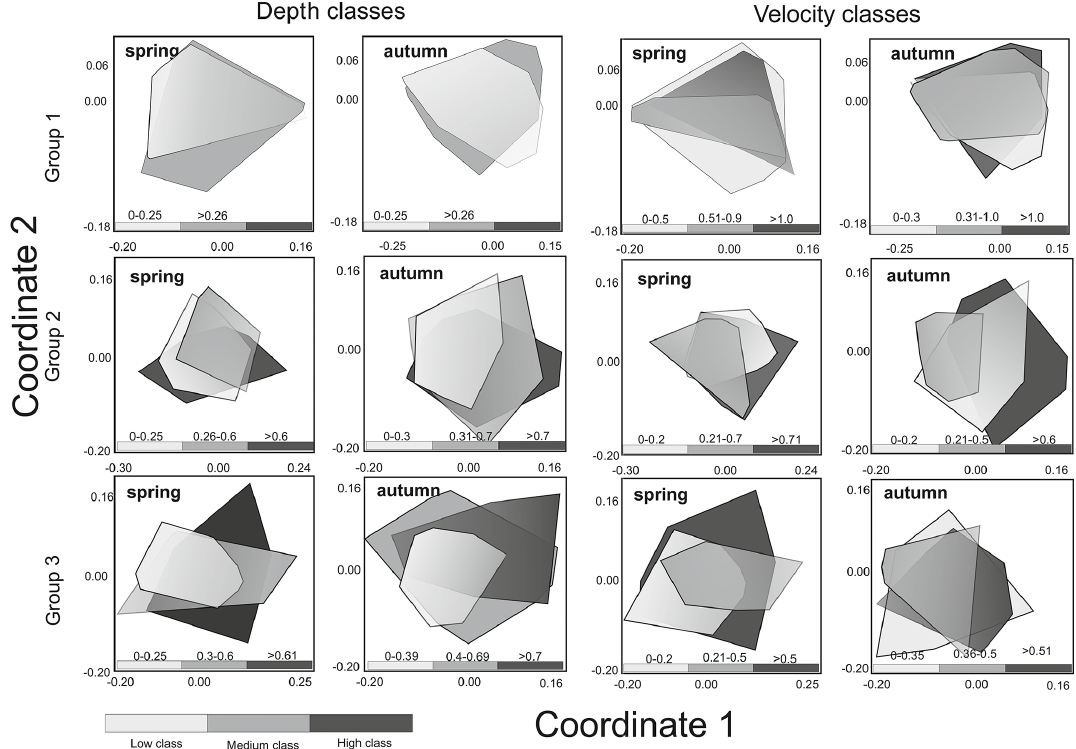
Figure 4. Non-metric multidimensional scaling (NMDS) of macroinvertebrate taxonomic composition of three groups of rivers in the spring and autumn season according to velocity and depth ranges. Table 2. Results of ANOSIM analysis comparing macroinvertebrate assemblages between classes of velocity and depth measured for the three river groups in the spring and autumn season. p values marked with bold indicate statistically significant differences. Velocity